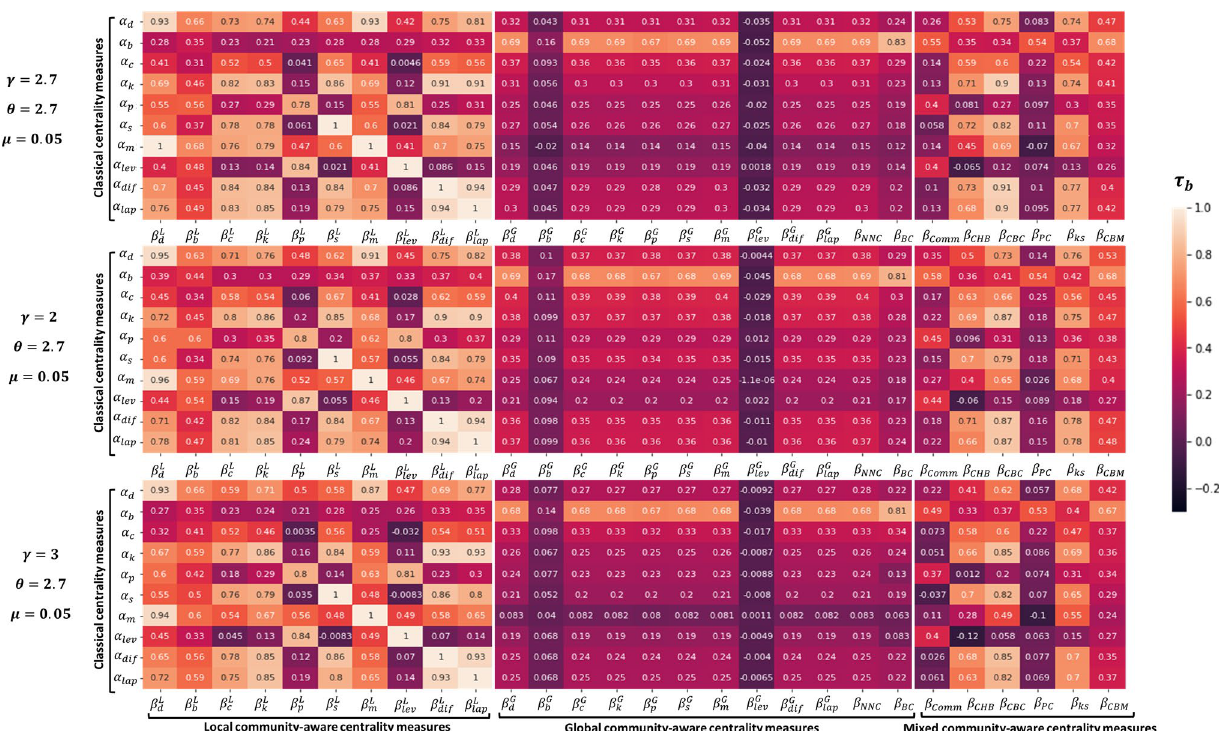
Figure 4. Heatmaps of Kendall’s Tau correlation of the various combinations between classical ( α i ) and community-aware ( β j ) centrality measures in synthetic networks. γ is the exponent of the degree distribution. Three values are used [2, 2.7, 3]. θ is the exponent of the community size distribution, and µ is the mixing parameter. The classical centrality measures are: α d = Degree, α b = Betweenness, α c = Closeness, α k = Katz, α p = PageRank, α s = Subgraph, α m = Maximum Neighborhood Component, α lev = Leverage, α dif = Diffusion, α lap = Laplacian. The local community-aware centrality measures are: ( β L d , β L b , β L c , β L k , β L p , β L s , β L m , β L lev , β L dif , β L lap ) = the local component of the classical centrality measures based on modular centrality. The global community-aware centrality measures are: ( β G d , β G b , β G c , β G k , β G p , β G s , β G m , β G lev , β G dif , β G lap ) = the global component of the classical centrality measures based on modular centrality, β NNC = Number of Neighboring Communities centrality, β BC = Bridging centrality. The mixed community-aware centrality measures are: β Comm = Comm centrality, β CHB = Community Hub-Bridge centrality, β CBC = Community-based centrality, β PC = Participation Coefficient, β ks = K-shell with Community centrality, β CBM = Community-based Mediator